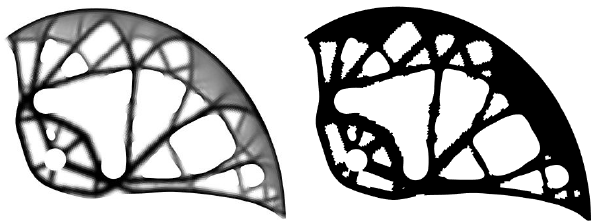
Figure 9. The second optimization run–density distribution field in grey-scale: black color—keep element, white color—remove element ( left ) and pseudo-density distribution field using the density limit value x lim = 0.1 ( right